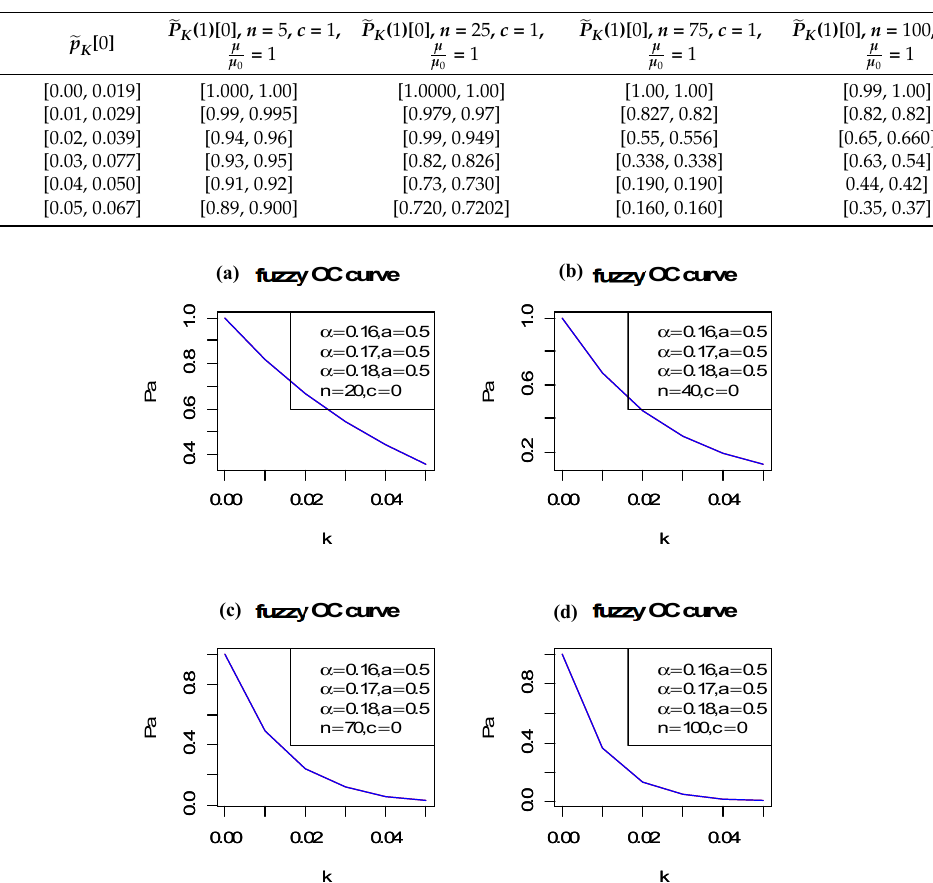
Table 3. The fuzzy acceptance probability of Birnbaum-Saunders distribution for c = 0.